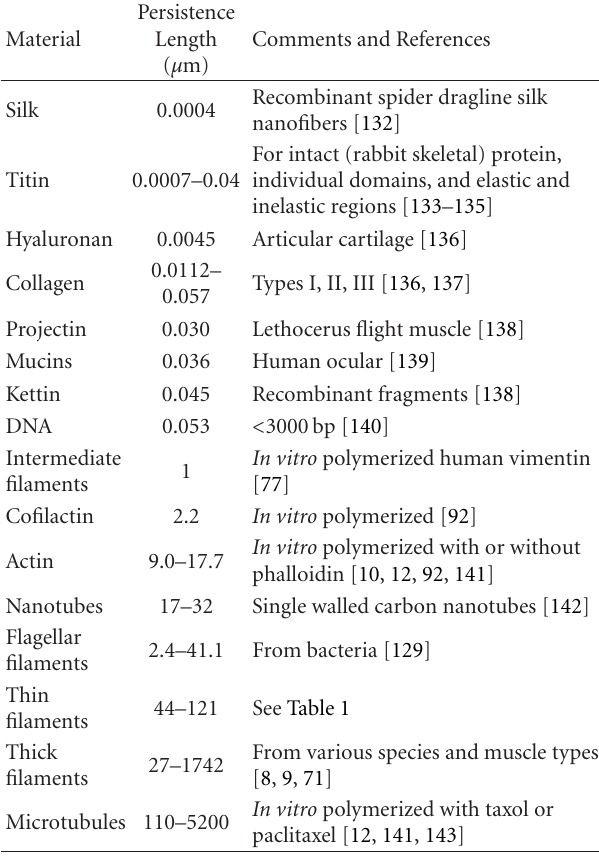
Table 2: Range of persistence length for biological polymers and